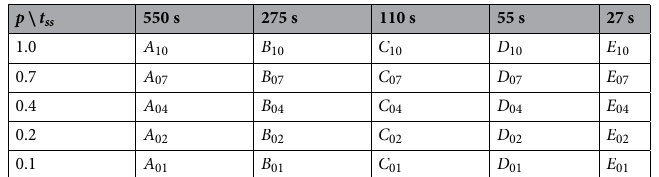
Table 1. Table of codes illustrating encoding and decoding waveforms symbols in the form of different values of p and t ss in v c ( t ) = V cc ( t / t ss ) p . We will be using the superscripts “ c ” and “ d ” for charge and discharge, respectively. For example A c 10 refers to the code A 10 during charge while A d 10 refers to the same code during discharge.